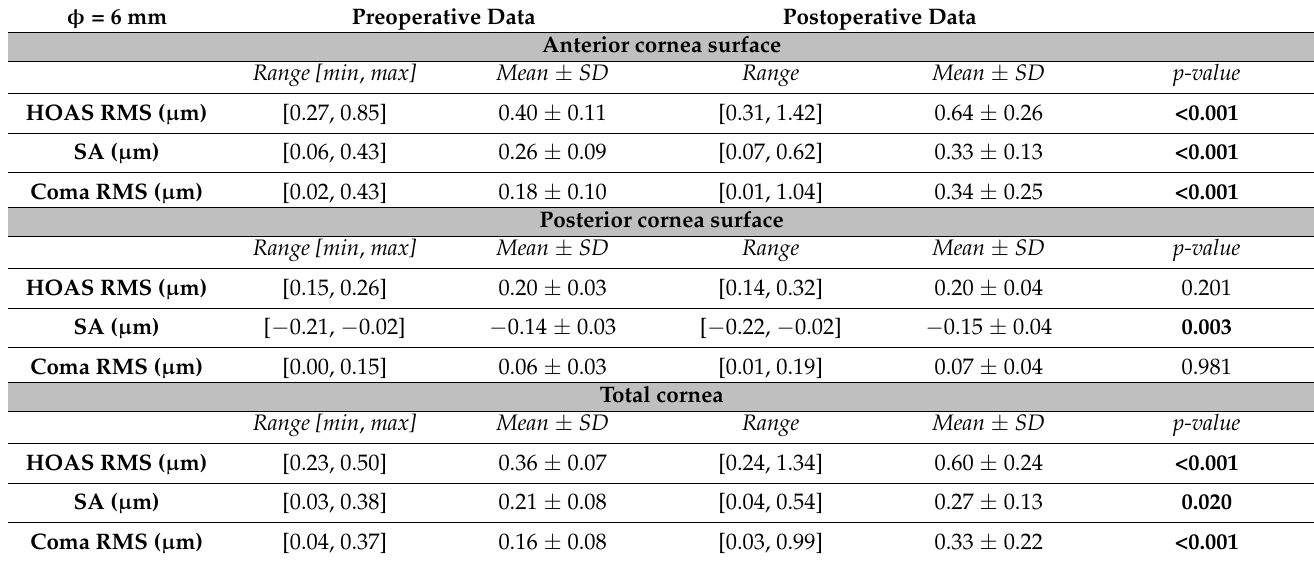
Table 2. Comparison of preoperative and postoperative of root mean square high-order aberrations (RMS HOAS), spherical aberration (SA) and RMS coma measured in microns ( µ m). The ranges, the mean and the standard deviation of the anterior and posterior cornea surfaces and total cornea are presented as well as the result of the statistical analysis ( p -value). Statistically significant values are highlighted in bold. All measures have been made for a pupil diameter of 6 mm.